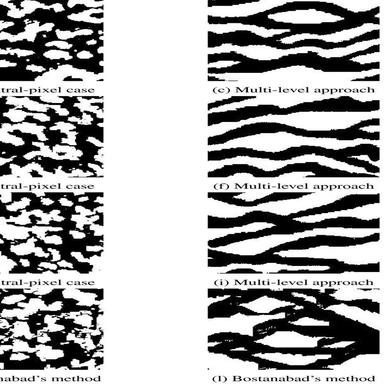
Representative reconstruction results (image size: 200 × 200 pixels) by using the proposed method and Bandstand's method.